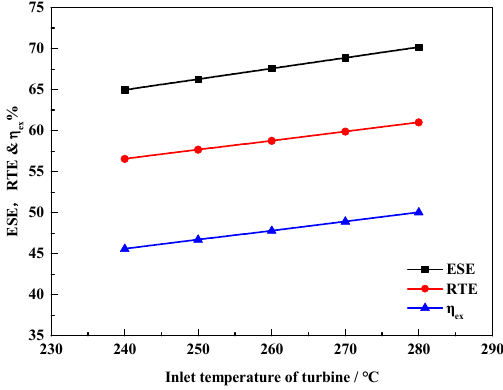
Figure 8 . Effect of inlet air turbine temperature on ESE, RTE, and η ex.